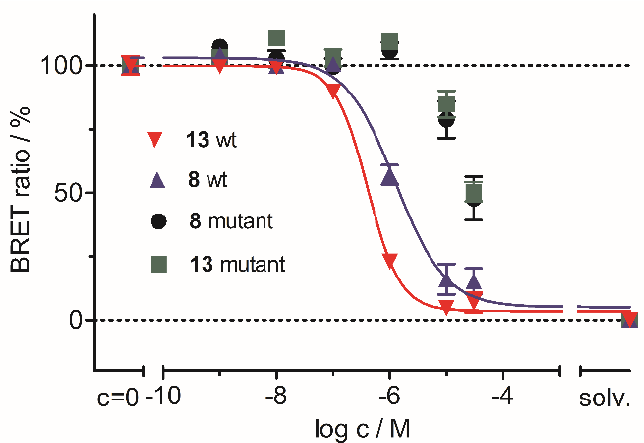
Figure 6. Determination of the IC 50 values of 8 and 13 for wildtype JNK3-NLuc and for JNK3(C154A)-NLuc in a NanoBRET TM TE intracellular JNK3 assay.